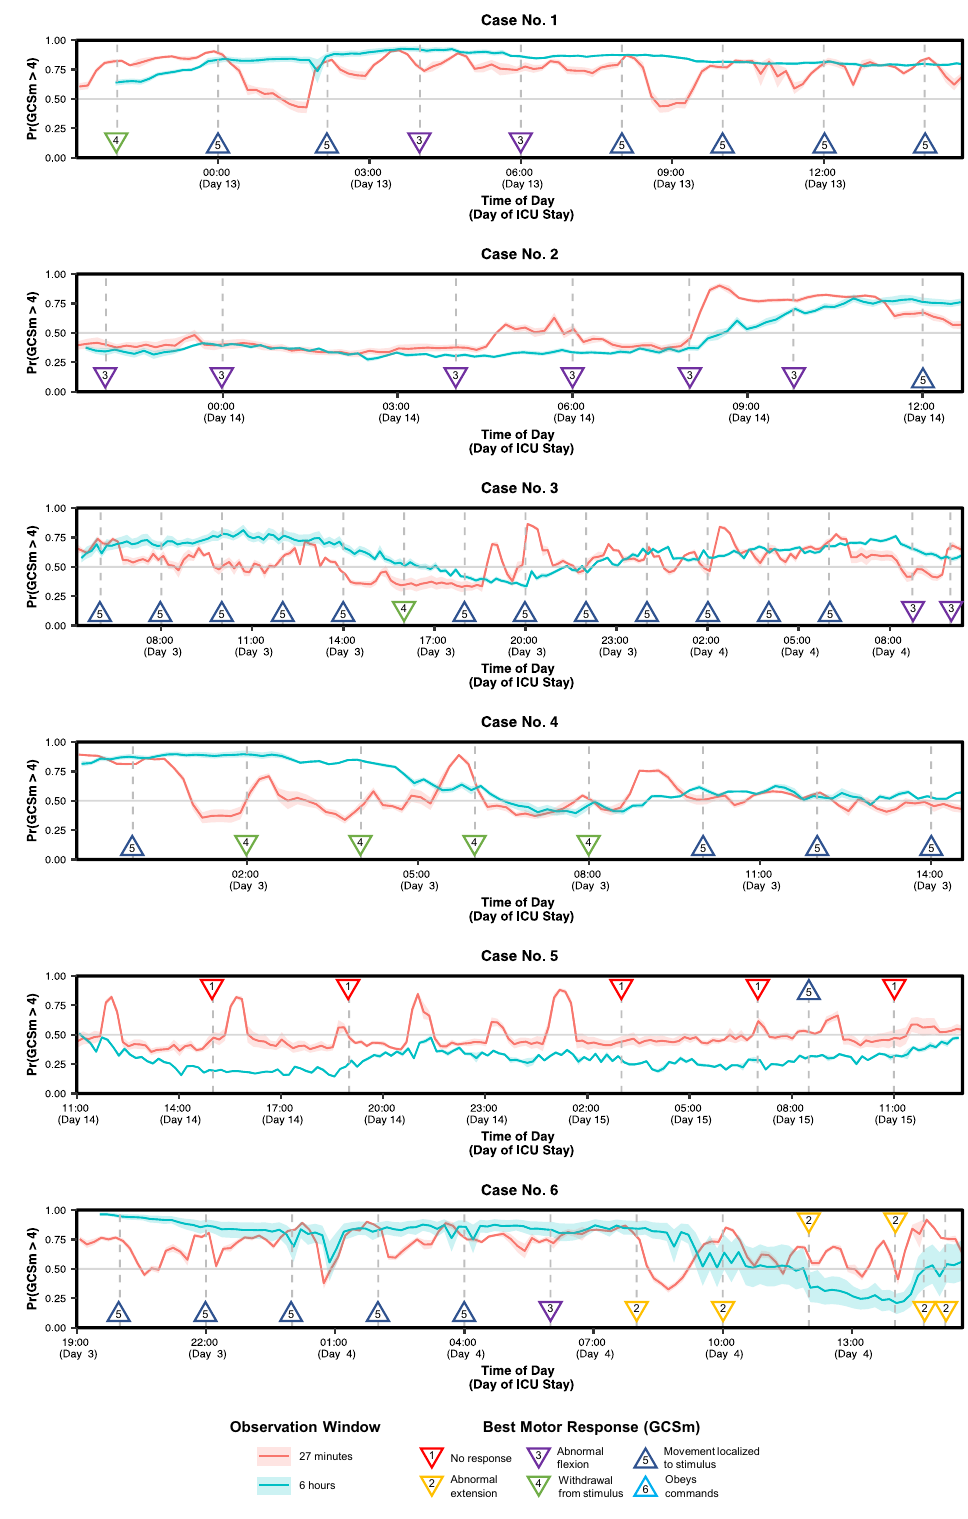
Figure 5. Retrospective case study analysis of accelerometry-based detection of motor function in six patients who experienced relevant transition. The red and blue lines correspond to the predicted probabilities returned every 10 min by models trained on all other patients on short (27 min) and long (6 h) observation windows respectively. The predictions from the shorter observation window (red line) respond quicklier to transient changes in the motor component score of the Glasgow Coma Scale (GCSm) (e.g., Case No. 2) while the predictions from the longer observation window (blue line) responds with greater stability to persistent GCSm transitions (e.g., Case No. 6). Shaded areas are 95% confidence intervals derived using bootstrapping (10,000 resamples) to represent the variation across nine missing value imputations. Upward triangle markers designate GCSm > 4 while downward triangle markers designate GCSm ≤